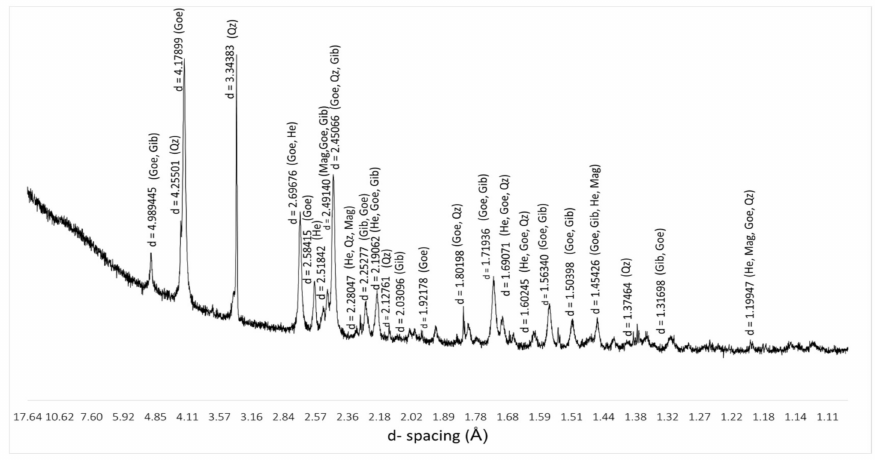
Figure 3. X-ray di ff raction pattern of the size fraction − 45 µ m of the amphibolitic itabirite (ROM).